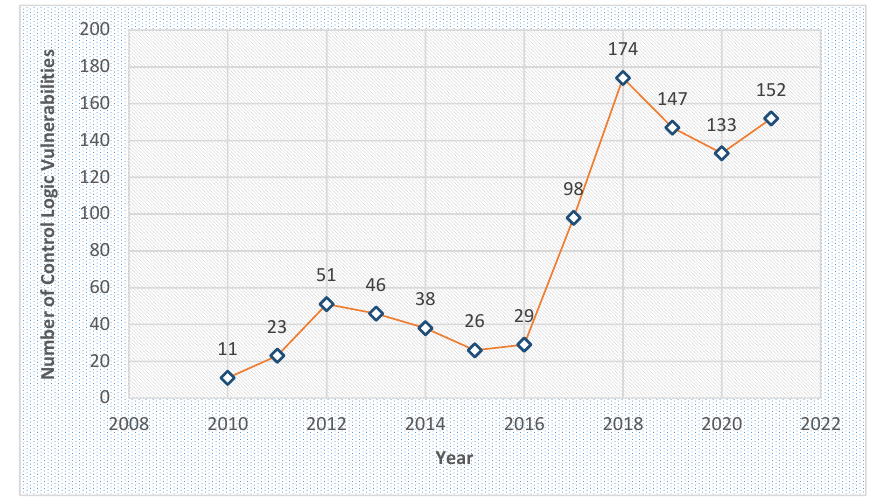
Figure 1. The number of related control logic vulnerabilities reported per